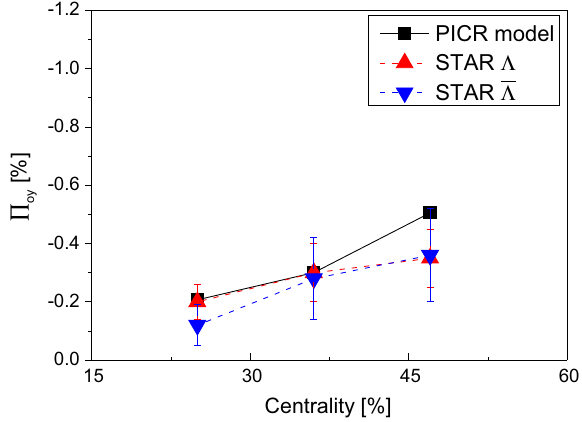
Fig. 1 The global polarization for Au + Au 200 GeV collisions at three different centralities: c = 25% , 36% , 46%. Our simulation results (black symbols), by using the PICR hydrodynamic model, shows good agreement with the STAR’s experimental data (red and blue